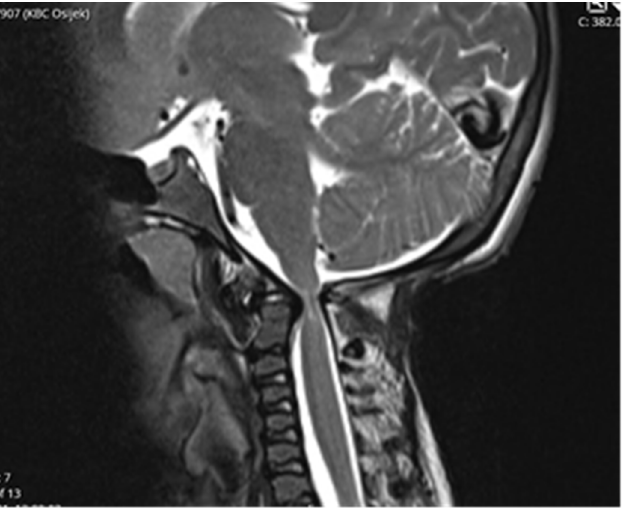
Figure 5. Postoperative MRI revealed insignificant radiological differences comparing to preopera ‐ tive scanning with persistent myelopathy (15 years of age).